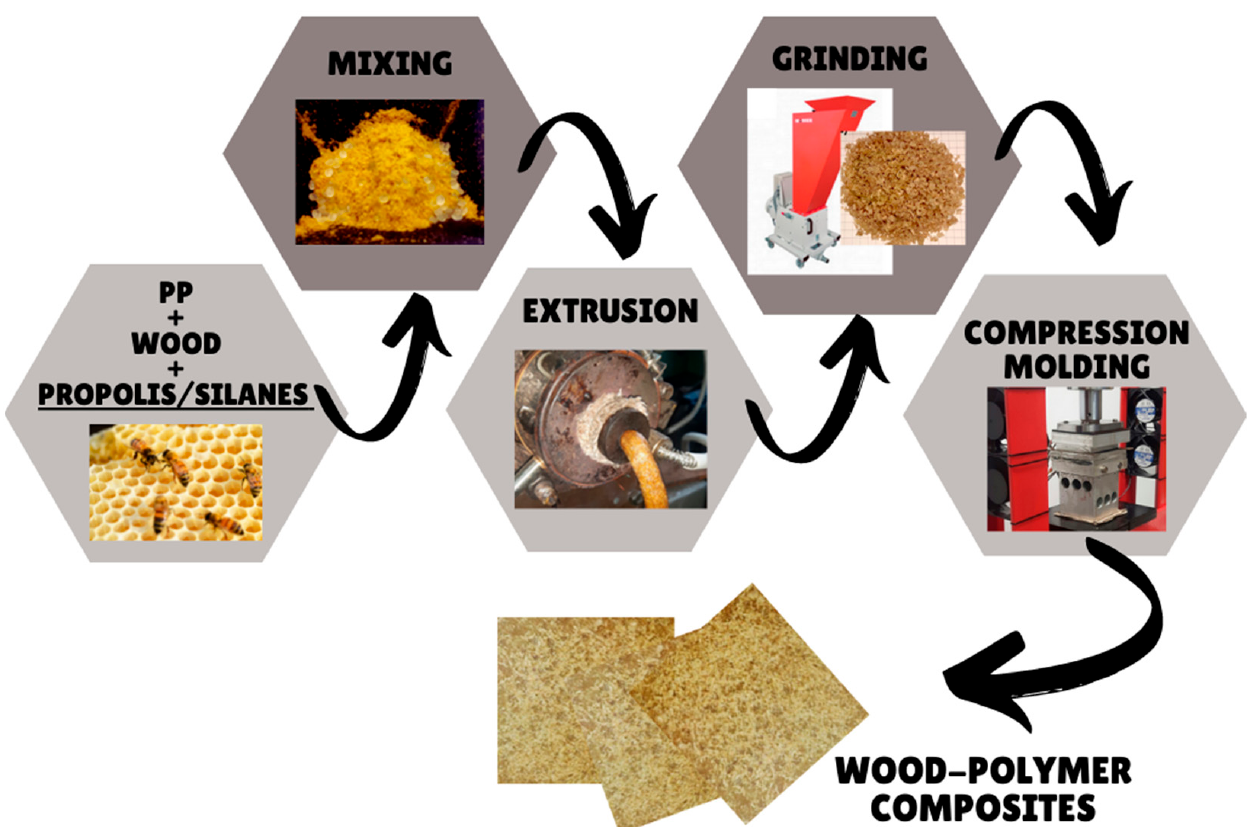
Figure 1. The procedure for the preparation of composites.